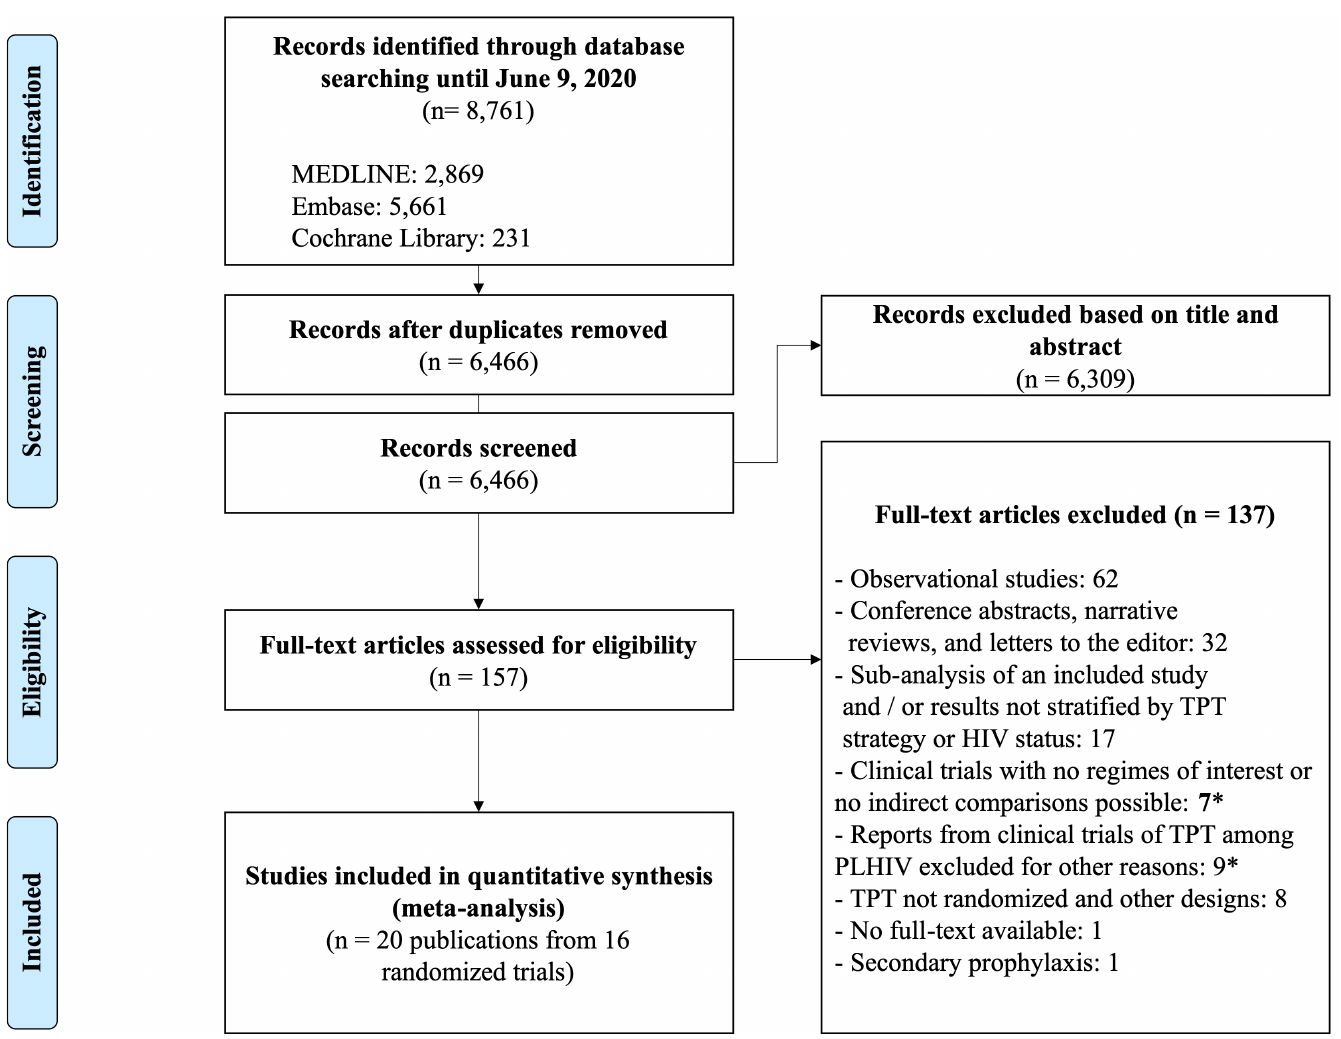
Fig 1. Flowchart of study selection. � For further detail on the reasons for exclusion, please refer to Table C in S1 File. PLHIV, people living with HIV; TPT, tuberculosis preventive therapy. [51]; a third excluded study compared 12 weeks of an enhanced opportunistic infection prophy- laxis versus trimethoprim-sulfamethoxazole, but both arms received isoniazid [52,53];a fourth comparing 2 months of rifampin and pyrazinamide (2RZ) versus 9H used interchangeably rifam- pin or rifabutin and reported results together [54]; a fifth comparing 12H versus placebo offered isoniazid to the placebo arm during the trial [55]; and a sixth comparing 6H (daily or thrice a week) versus placebo and did not report stratified results for dosing schedules [56].